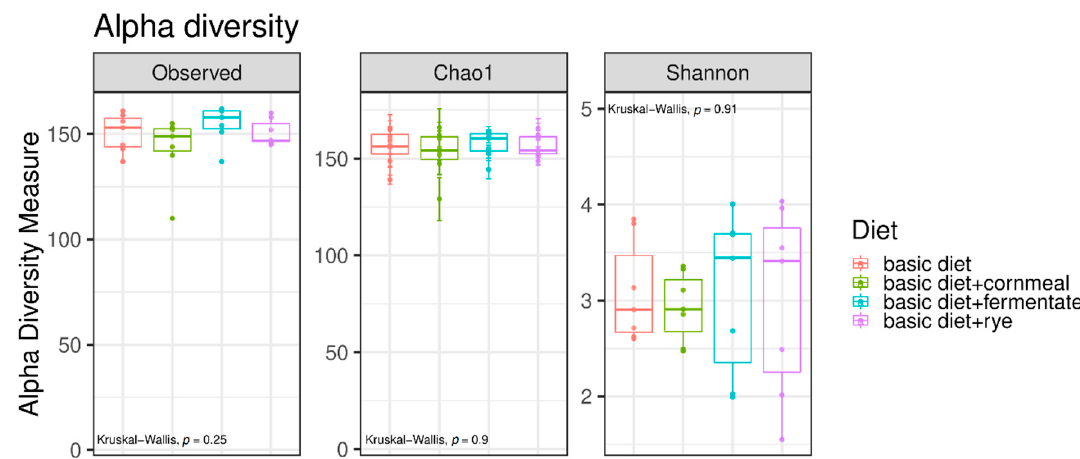
Figure 2. Alpha diversity in faecal samples of dogs. Box plots showing alpha diversity in samples using the species richness estimators Observed Species, Chao1 and Shannon index. Comparisons of